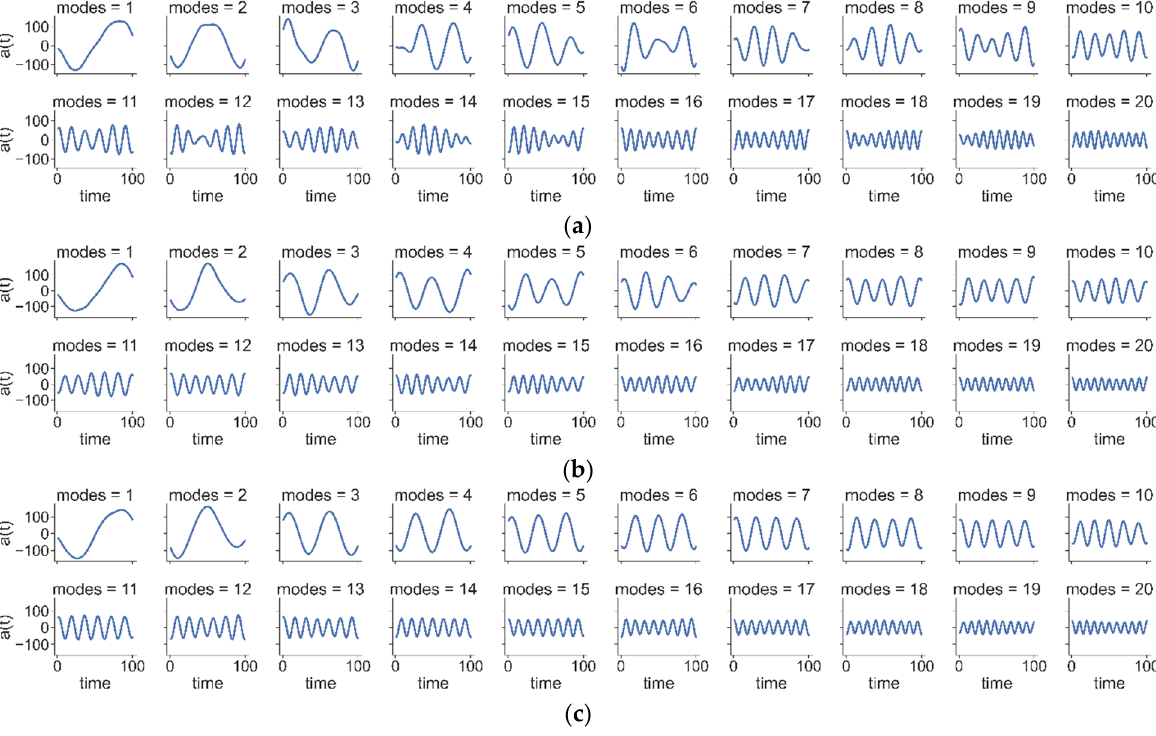
Figure 10. Time coefficients of the first 20 modes behind the MVG with ( a ) Ma = 1.5, ( b ) Ma = 2.0, ( c ) Ma = 2.5.